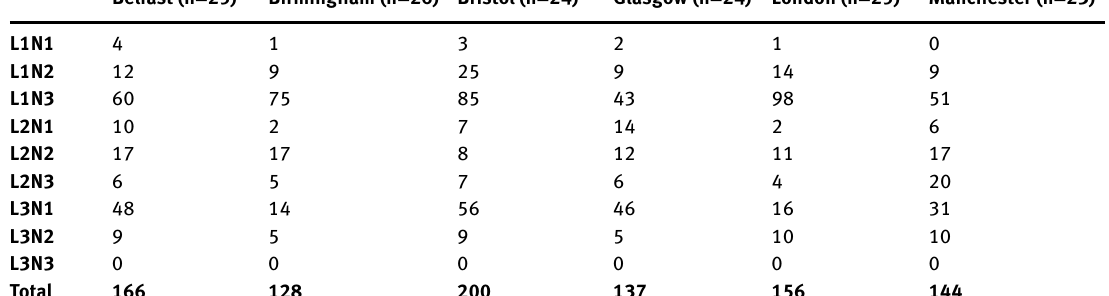
Table 4: Distribution of fingerspelling-related tokens across nativisation model per region